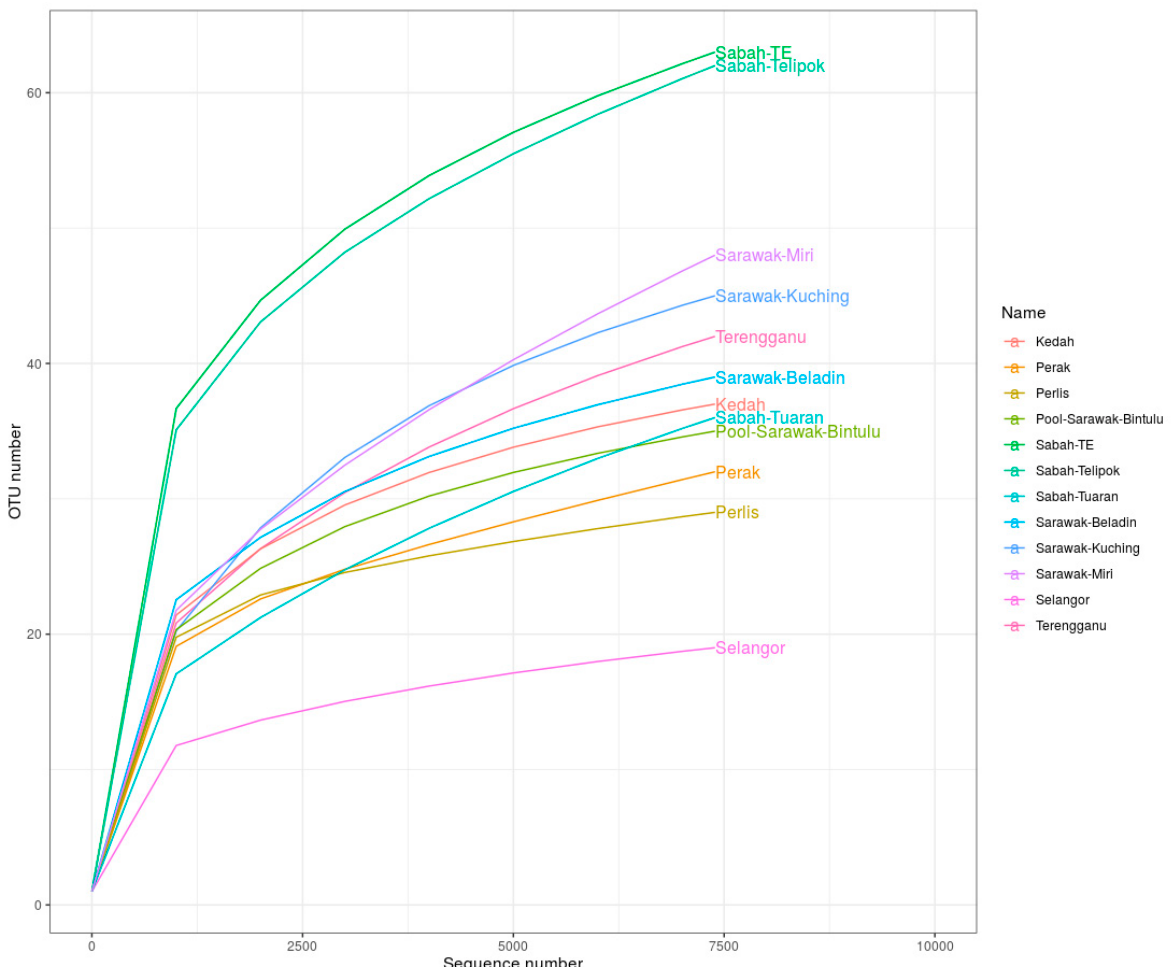
Figure 2. The rarefaction curve of the trnL gene sequence for different localities of H. itama calculated for operational taxonomic units (OTUs) at 97% similarity. Table 2. The numbers of effective trnL gene sequences. Number of observed OTUs, alpha diversity indices for the plant DNA from 12 localities of H. itama.